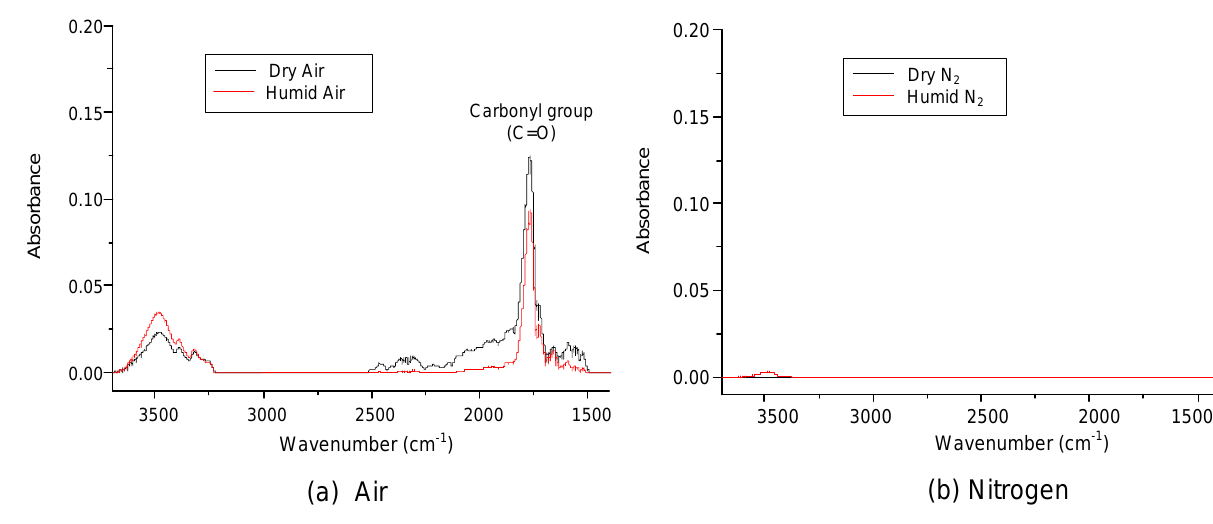
Figure 6. Chemical analysis of aerosol using DRIFT spectrometer; (a) in air (b) in N Benzene concentration was about 250